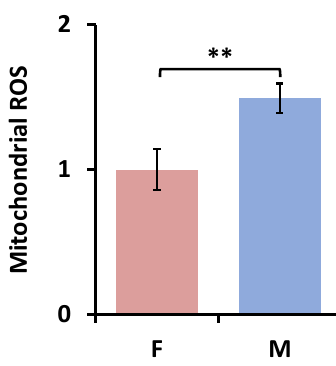
Figure 7. Sex-associated difference in the mitochondrial ROS level (normalized to females) in AM from SP-A2 mice exposed to ozone (Mean ± SD). F-female; M-male. ** p < 0.01.